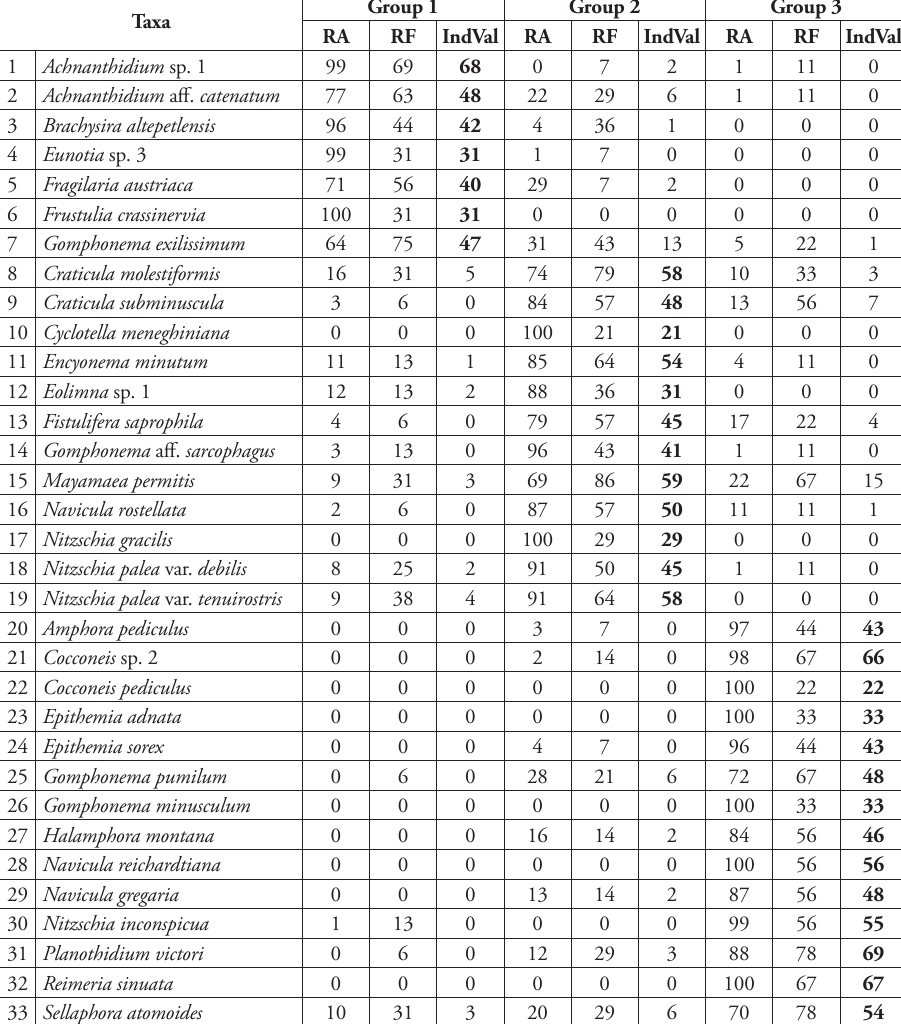
Table 4. Indicator taxa from the three groups visualized after the CCA. The indicator value of the taxa is accompanied by their relative abundance (RA) and relative frequency (RF) values. Significant IndVals ( p < 0.05) are indicated in